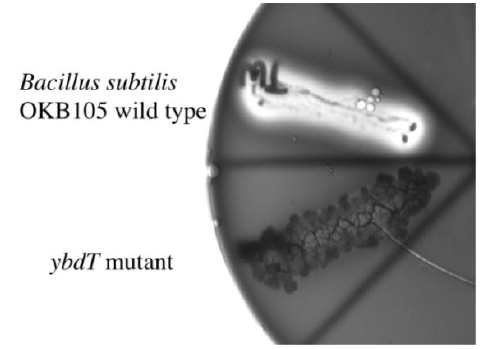
Figure 1. β-hemolytic activity of the OKB105 cells compared to NHY1, the ybdT mutant. Blood agar plate was streaked with a single colony of OKB105 (wild-type) or NHY1 ( ybdT mutant) cells. β-Hemolysis occurred within 24 h in OKB105 cells with clearing of blood agar and the appearance of a green sheen. NHY1 cells showed delayed hemolysis, which occurred after 48 h of incubation, and was not as extensive as that observed with OKB105 cells. The picture was taken 24 h after